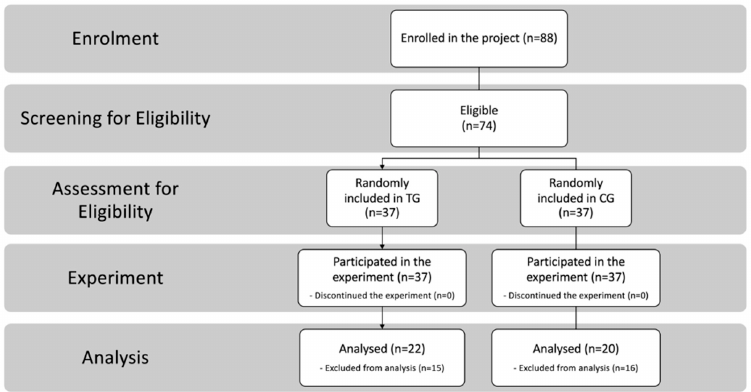
Figure 1. Subject recruitment, assignment, and assessment procedures.